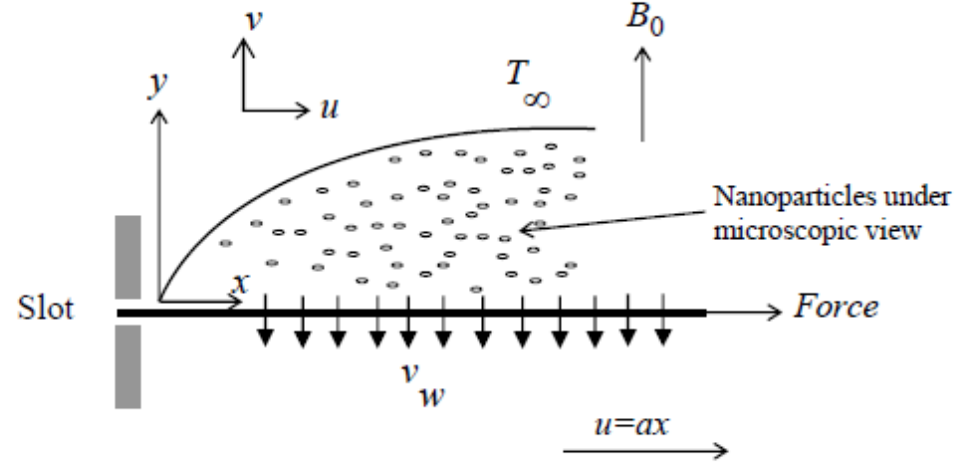
Figure 1. Schematic diagram for the nanofluid